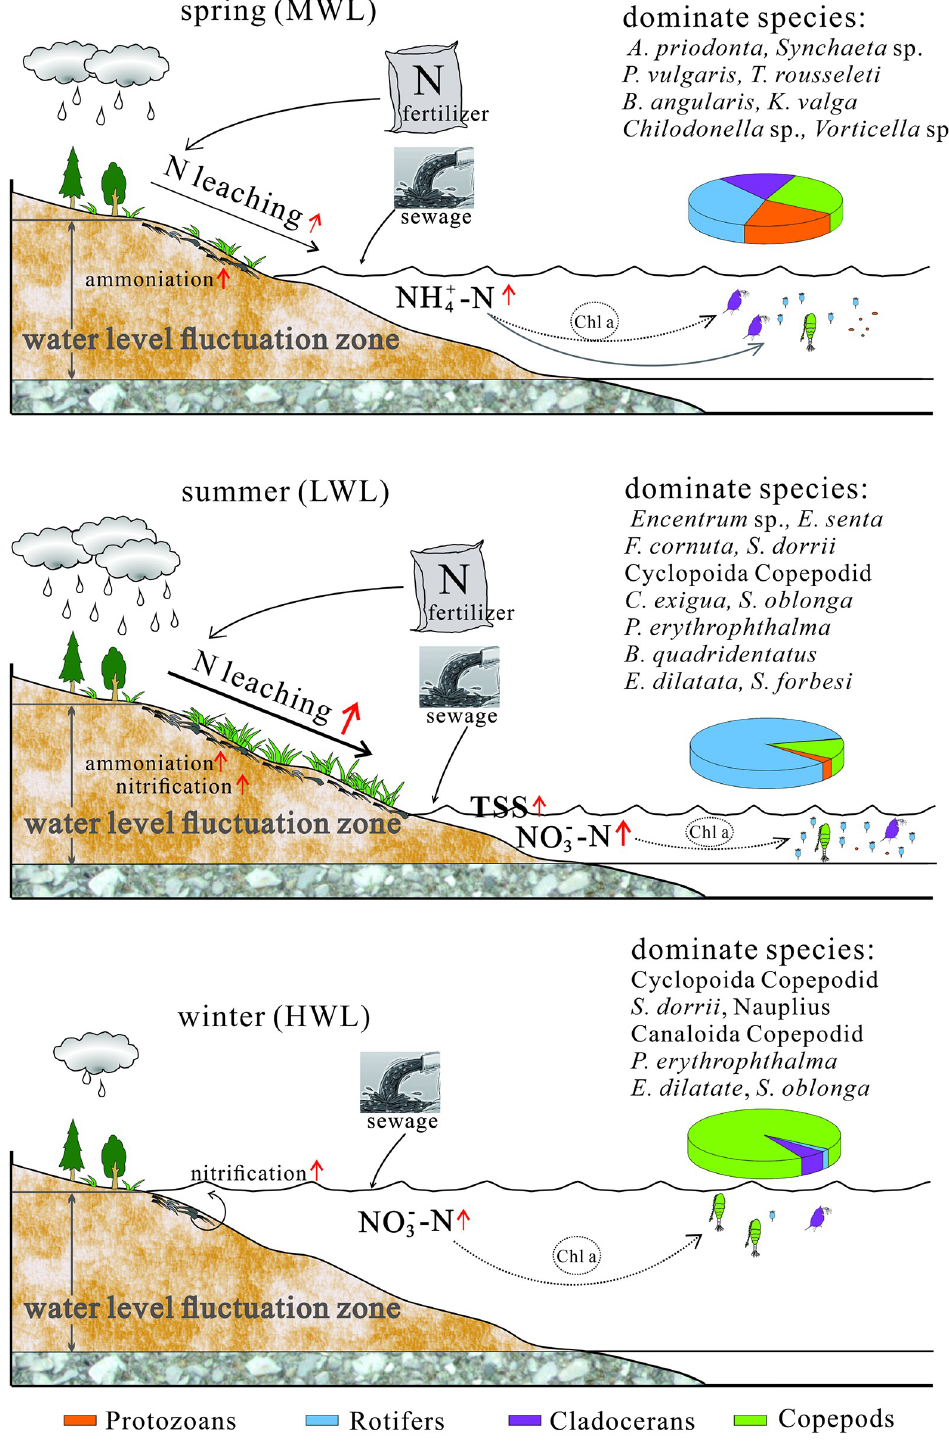
Fig 8. The conceptual graph of relationships between hydrological variations and dominant zooplankton species. Only show the species with biomass proportion > 5% and frequency � 5 in each season.